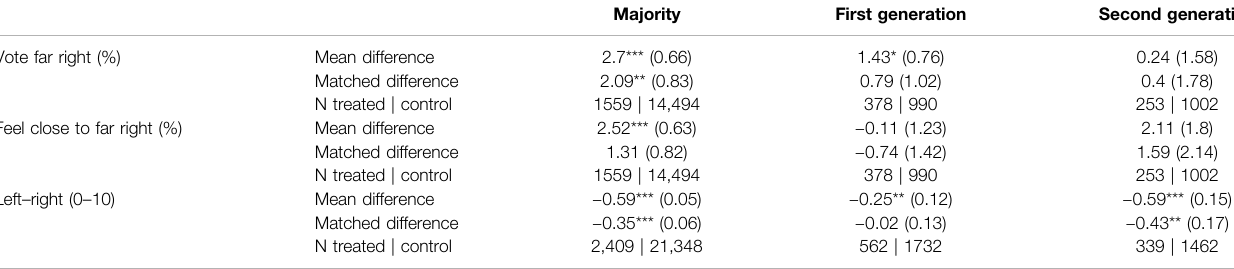
TABLE 4 | Difference in voting and political attitudes for inhabitants of ethnic enclaves and those in majority